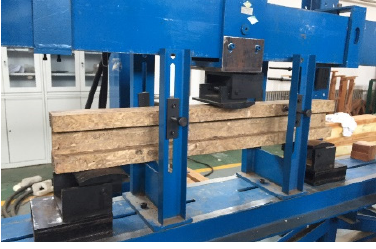
Figure 2. Shear test loading device and schematic diagram.